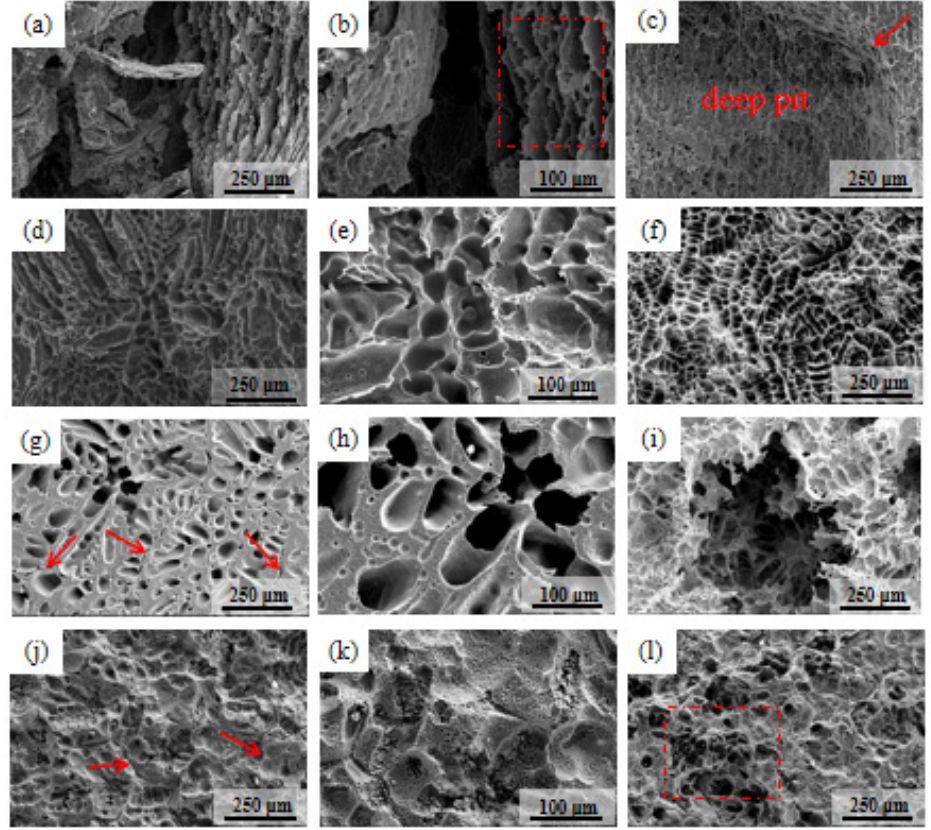
Figure 10. The surface morphologies of ( a , b ) Mg-0.5Sn, ( d , e ) Mg-1Sn, ( g , h ) Mg-2.5Sn and ( j , k ) Mg- 4Sn anodes after 10 h of discharge at 1 mA cm − 2 without the discharge products; surface morphologies of ( c ) Mg-0.5Sn, ( f ) Mg-1Sn, ( i ) Mg-2.5Sn, and ( l ) Mg-4Sn anodes after 10 h of discharge at 40 mA cm − 2 without the discharge products.